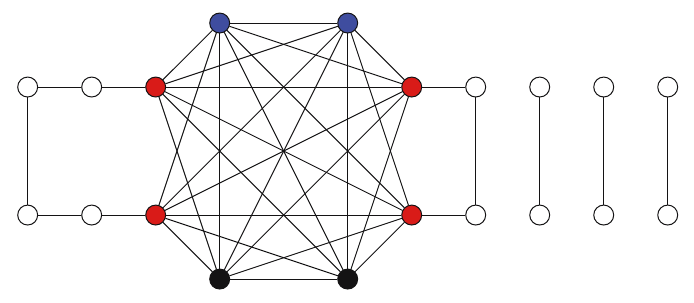
Figure 3: The strong resolving graph B SR of the graph given in Figure